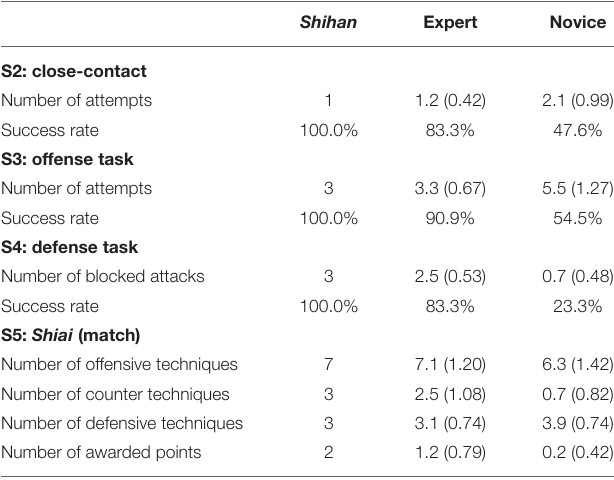
TABLE 1 | Mean (SD) number of attempts in S2 and S3, number of blocked attacks in S4, and number of offensive, counter, and defensive techniques and awarded points in S5 between expert and novice groups.